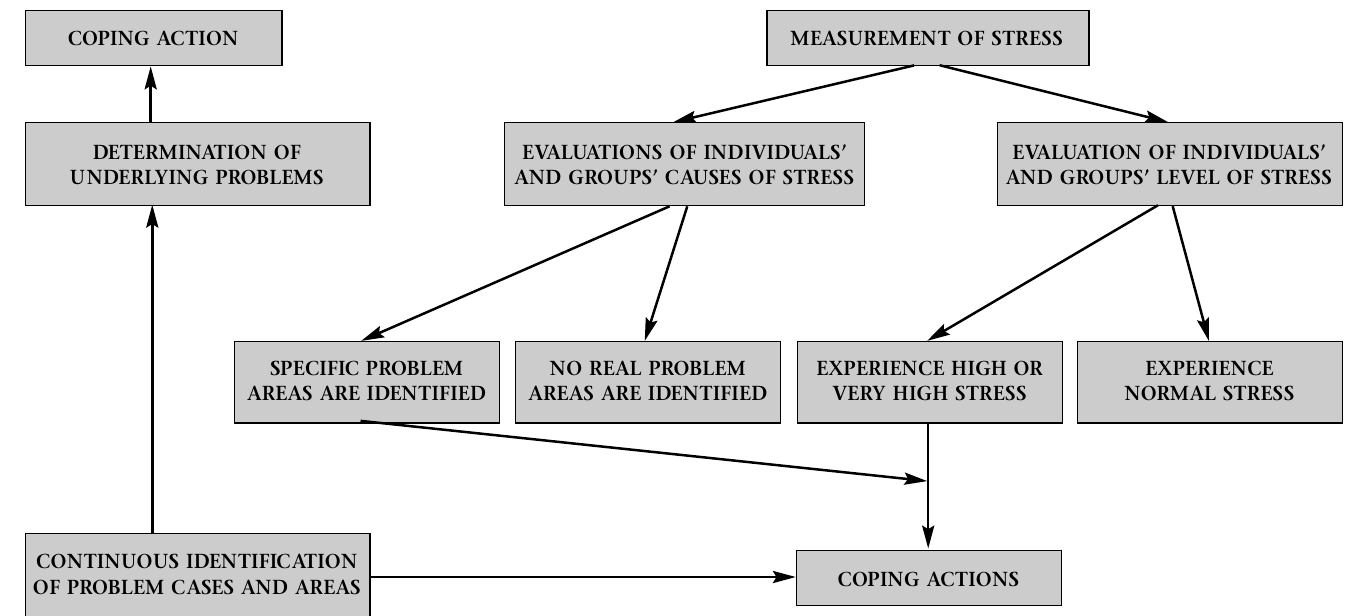
Figure 1: Measuring stress in the work context (Quick & Quick, 1994,